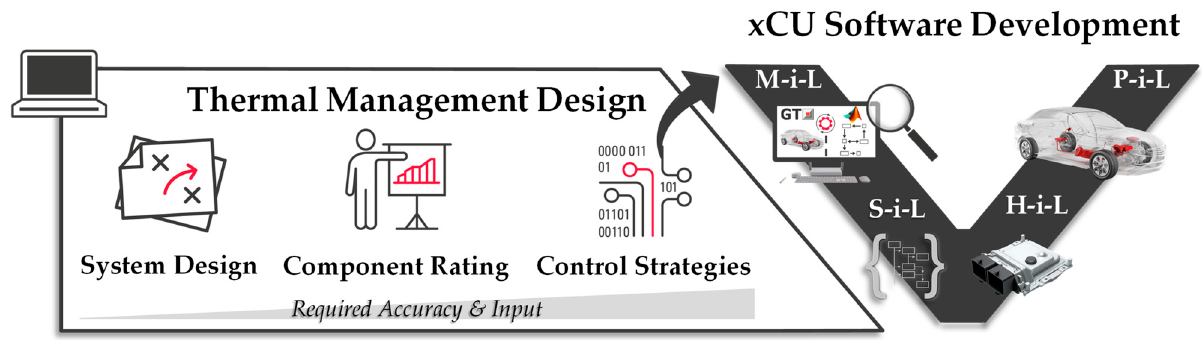
Figure 2. Simulation-based thermal management design applications and corresponding V-model for control strategy development.